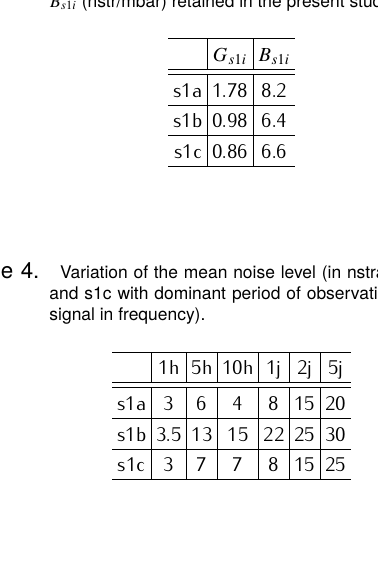
Table 3. Inducedstrainonagauge i causedbygulfwaterlevelfluctu- ation G s 1 i (nstr/mbar)andbybarometricpressurefluctuation B s 1 i (nstr/mbar) retained in the present study.